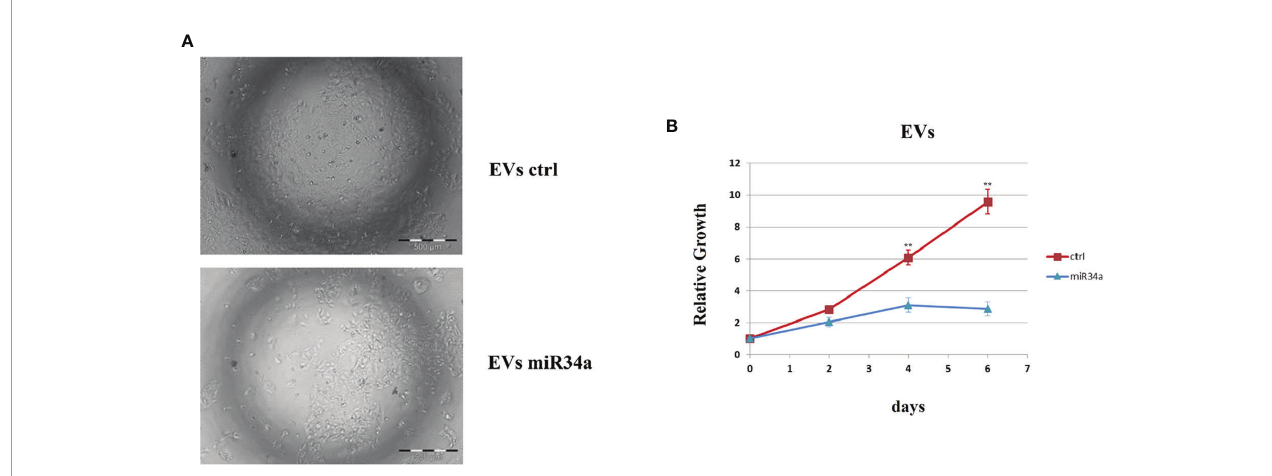
FIGURE 6 | Evaluation of Huh7.5 control and treated with miR34a-loaded exosomes. (A) Bright fi eld microscopy and (B) cell growth curve by CellTiter-Glo demonstrated that miR34-loaded EVs clearly reduce the cell growth rate (**p value ≤ 0.005). The reported data are representative of experiments performed in triplicate on three different samples.